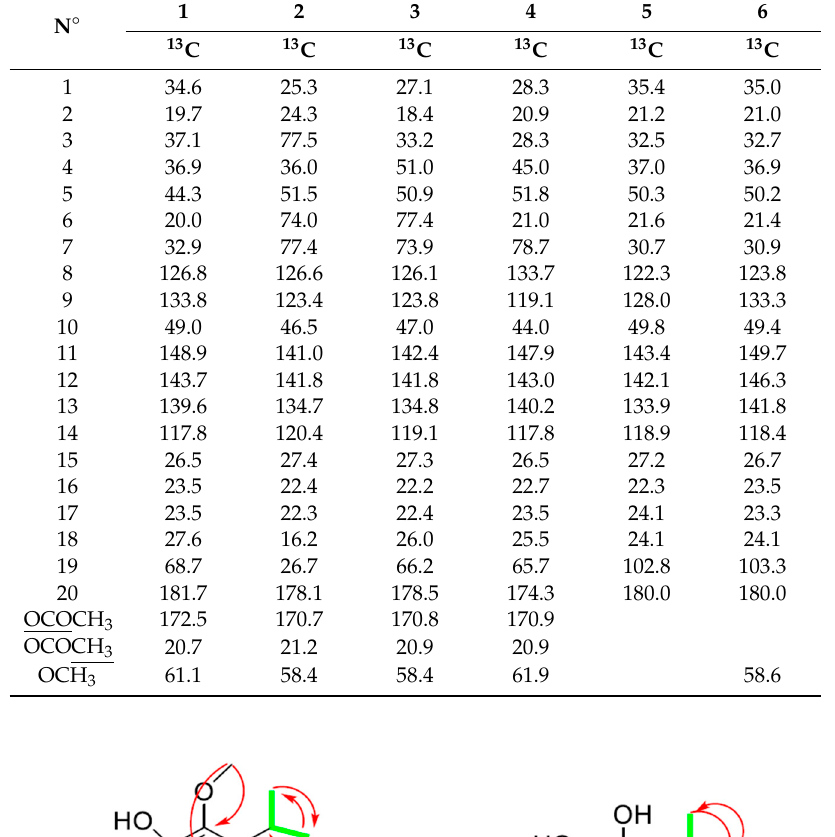
Table 2. NMR spectroscopic data assignments (100 MHz) for compounds 1 – 6 ( δ in ppm) in CDCl 3 .